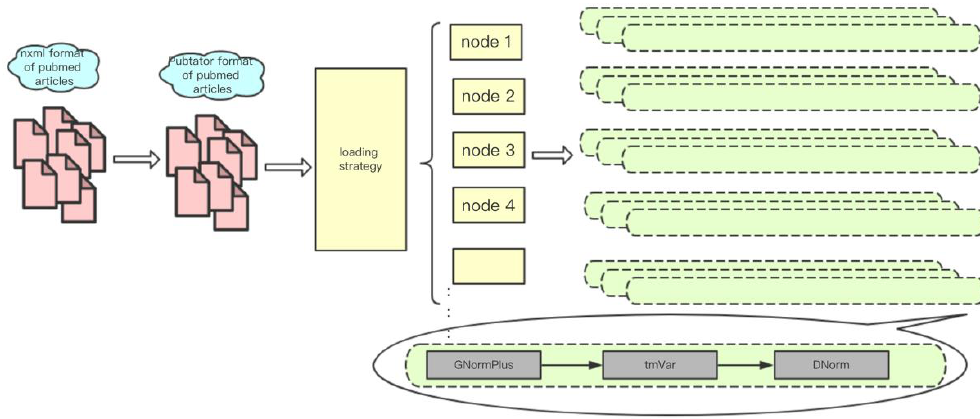
Figure 5. The implementation and deployment of paraBTM in large-scale parallel environment.